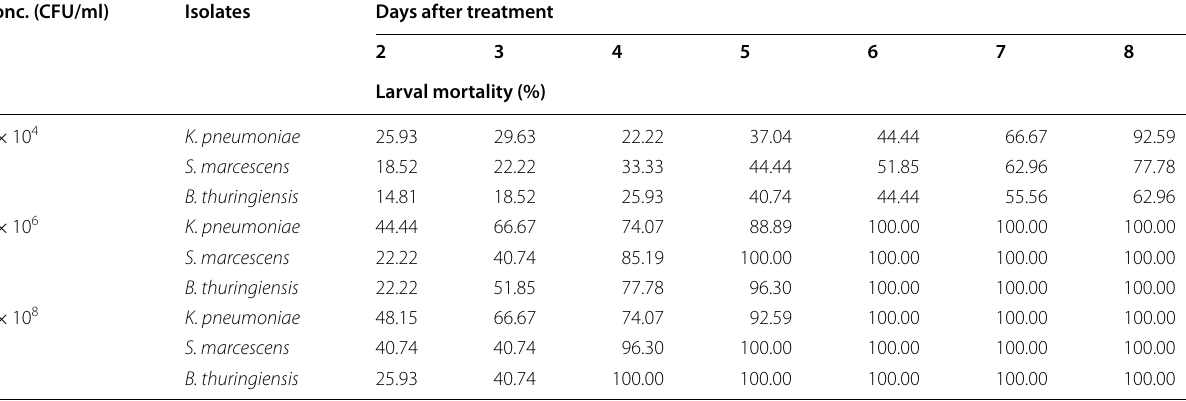
Table 1 Larval mortality percentages of three bacterial isolates against the second instar larvae of red palm weevil, Rhynchophorus ferrugineus , under controlled laboratory